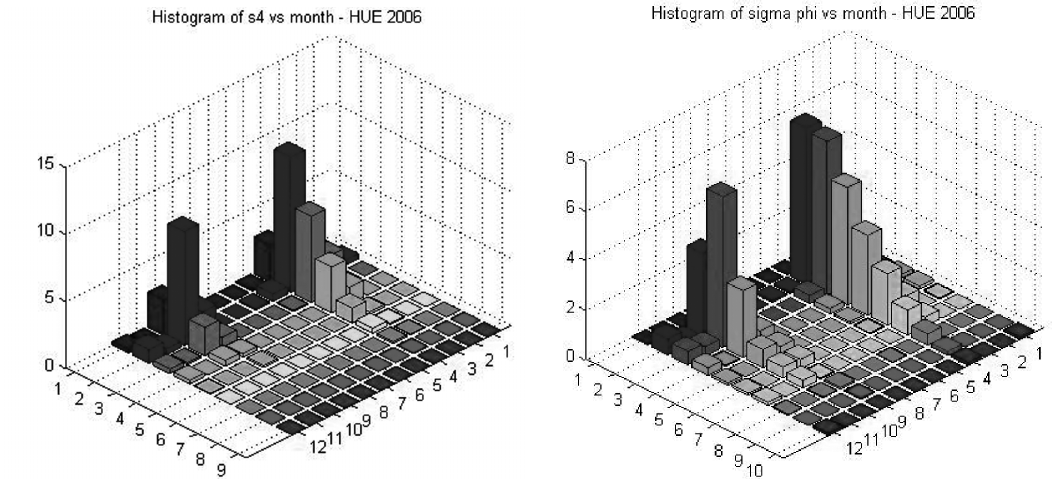
Fig. 2. Histogram of intensity and phase scintillations recorded in Vietnam (x axis S 4 to be multiplied by .1, y axis the month number, z axis the relative number of